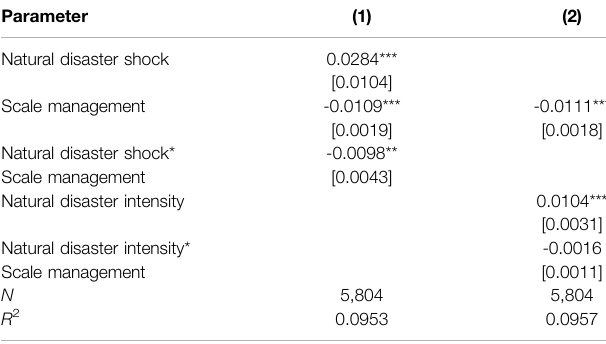
TABLE 7 | Test results of the moderating effect of scale